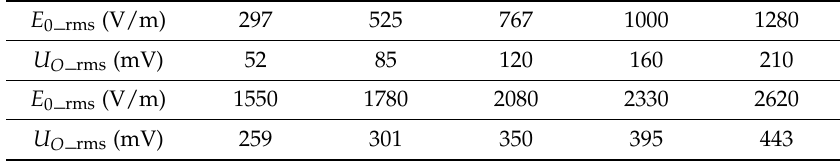
Table 5. Statistical data of E 0_rms and U O _rms when fixing measurement point.